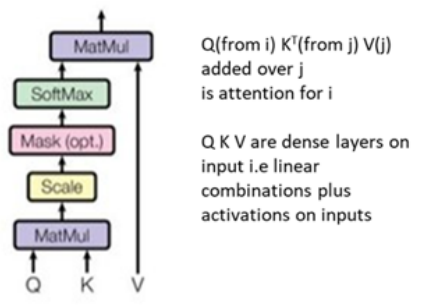
Figure 14. The Q, K, V layers of the attention mechanism.